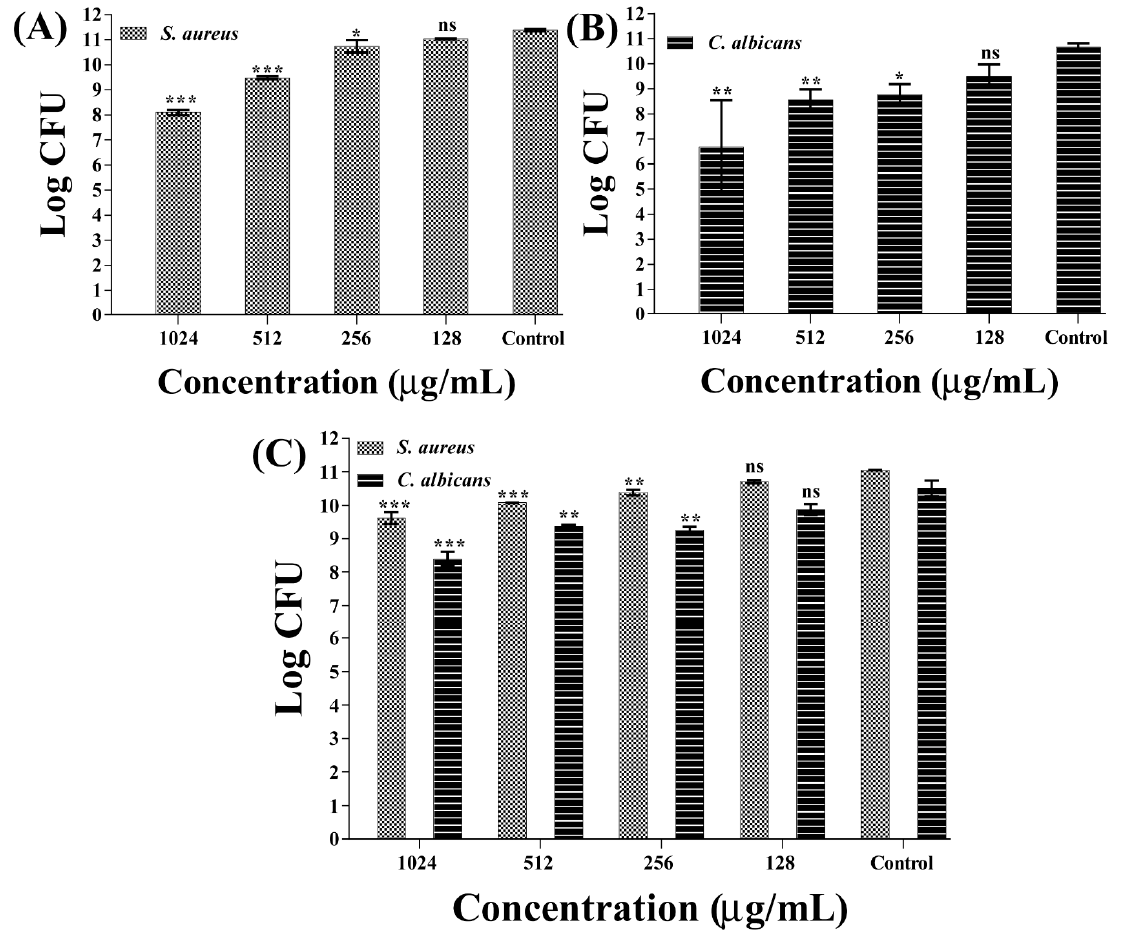
Figure 8. Mature biofilm eradication by β -c-AuNPs. ( A ) CFU of S. aureus cells, ( B ) CFU of C. albicans cells, and ( C ) CFU of S. aureus and C. albicans from the mixed mature biofilm. *** p < 0.0001, ** p < 0.01, and * p < 0.05 are statistically significant compared to the control, whereas ns is